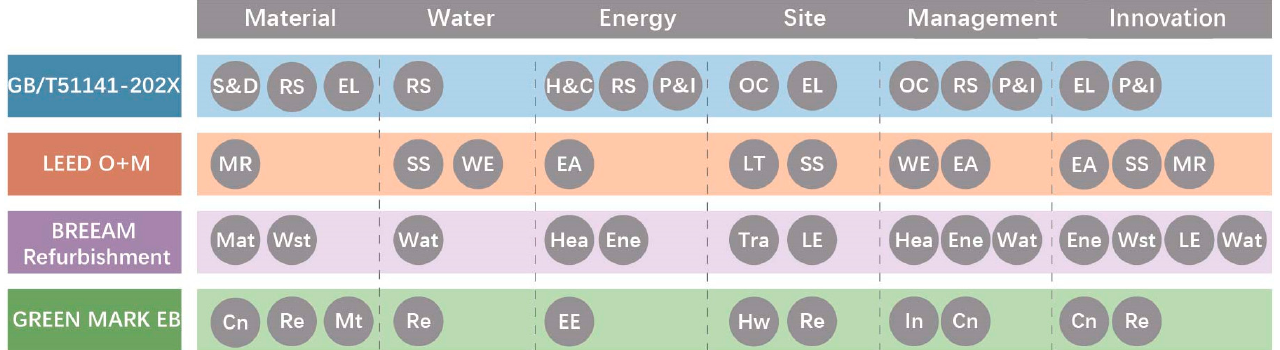
Figure 4. Scopes of related indicators.